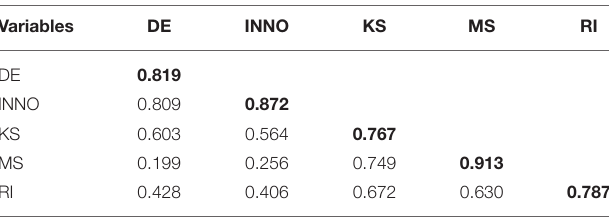
TABLE 3 | Fornell and Larcker criterion.